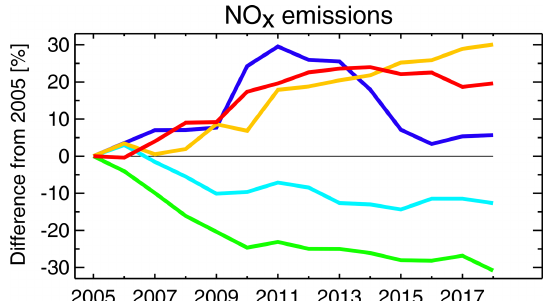
Figure 15. Time series of the difference (in%) of the annual mean a posteriori surface NO x emissions relative to the 2005 emissions in the period 2005–2018 for India (orange), China (blue), Europe (light blue), the Middle East (red), and the US